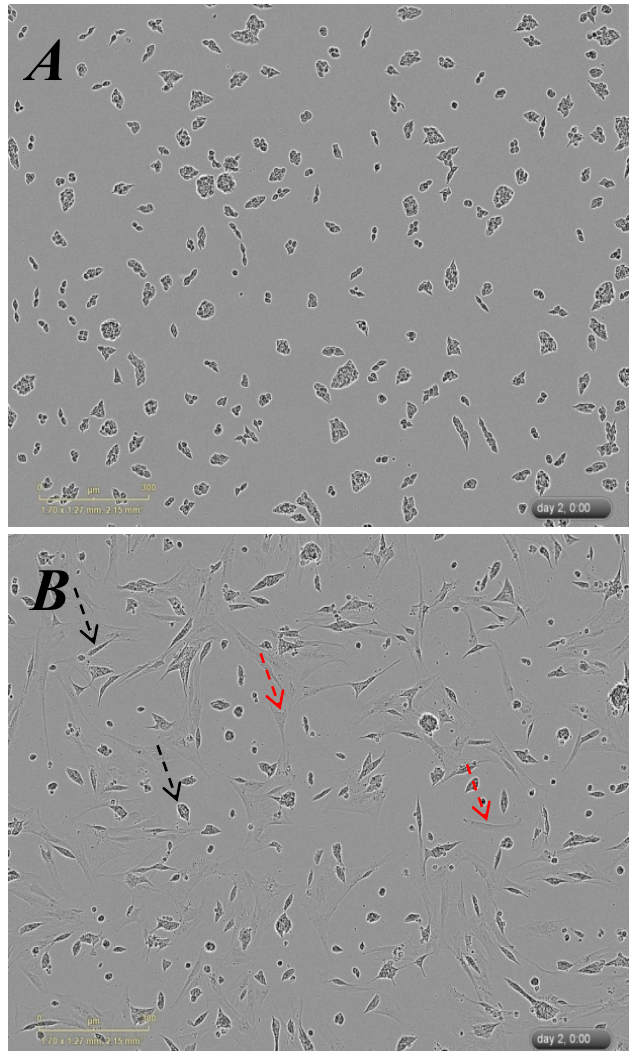
Figure A2 . AR4-2J/PSC co-culture . AR4-2J cells cultured alone ( A ) or co-cultured with pancreatic stellate cells (at AR4-2J/PSC ratio of 2:1) ( B ) at 48 h of culture or co-culture (imaged by Incucyte). Black and red arrows indicate AR4-2J and pancreatic stellate cells respectively in the co-culture ( B ). These micrographs are enlarged versions from Figure 5A, B. The scale bars are 300 μ m in ( A , B ).